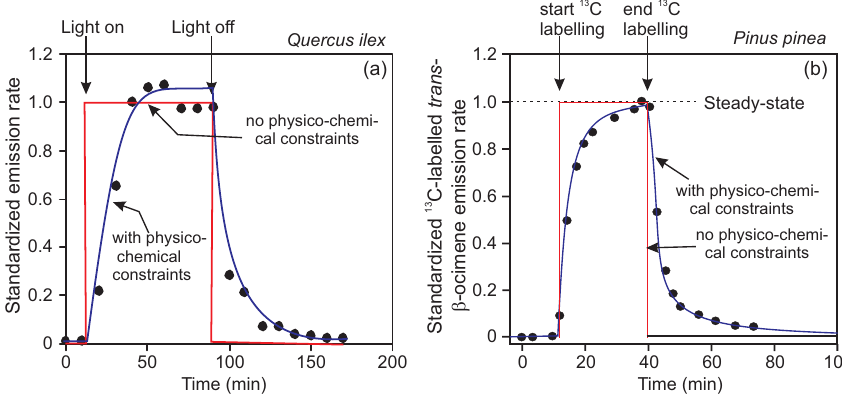
Fig. 4. Interaction of physiological and physico-chemical factors in determining the total light-dependent monoterpene emission rate in the Mediterranean evergreen sclerophyll Quercus ilex (a) (modified from Ciccioli et al., 1997b) and light-dependent emissions of monoterpene trans - β -ocimene in the Mediterranean conifer Pinus pinea (b) (modified from Noe et al., 2006) at a constant temperature of 30 ◦ C. (a) depicts the transient of the emission rates after light-dark changes, while (b) depicts the emissions of 13 C-labelled trans - β -ocimene following the switch from 12 CO 2 to 13 CO 2 in the gas-exchange chamber, and after a steady-state was reached in labeled trans - β -ocimene emissions, from 13 CO 12 CO 2 to 2 . Given that the synthesis of monoterpenes relies on a small chloroplastic carbon pool, application of a simple steady-state model initially developed for isoprene (Guenther et al., 1993) suggests that monoterpene emission rate immediately tracks the altered light intensity (a) and that in all the emitted trans - β -ocimene molecules at least one carbon atom is labeled by 13 C (b, simulation without the storage pool). In reality, reaching the steady-state is time-consuming due to non-specific monoterpene storage within the leaf liquid and lipid phases (Niinemets and Reichstein, 2002; Noe et al., 2006). This leads to time-lags in reaching the maximum monoterpene emission rates and continued release of monoterpenes from darkened leaves (a), as well as to time-lags in trans - β -ocimene labeling with 13 C and de-labeling after swapping back to 12 CO 2 . The best fit to the data can be obtained with a model including two leaf monoterpene pools, the faster pool presumably located in the leaf liquid phase and the slower pool presumably located in the leaf lipid phase (Niinemets and Reichstein, 2002; Noe et al., 2006). For (a), the half-time for the faster pool was 0.078h, while the half-time was 2.05h for the slower pool (Niinemets and Reichstein, 2002). For (b), the corresponding half-times obtained were 0.03h for the faster, and 0.26h for the slower pool (Noe et al.,